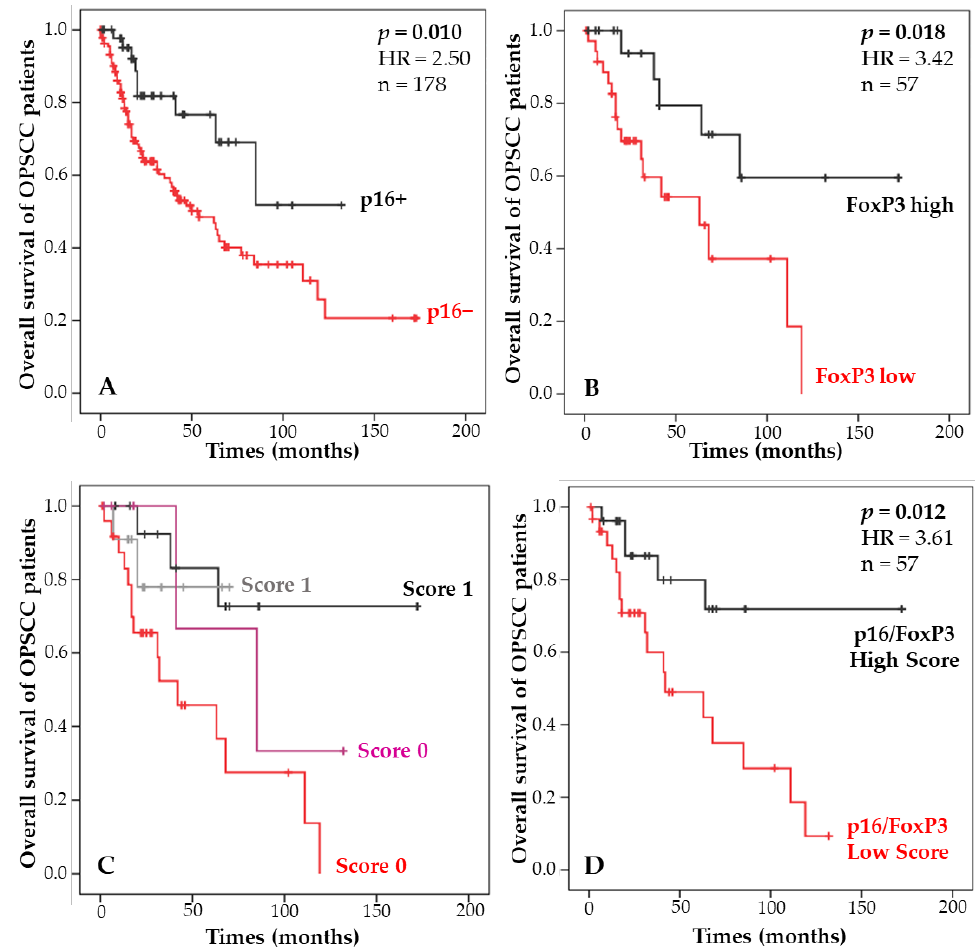
Figure 3. Kaplan-Meier curves of the OS of OPSCC patients according to p16 status ( A ), the number of FoxP3+ cells infiltrating the tumor ( B ), the combination of both parameters resulting in four groups ( C ), and the score combining p16 status and FoxP3 density ( D ).